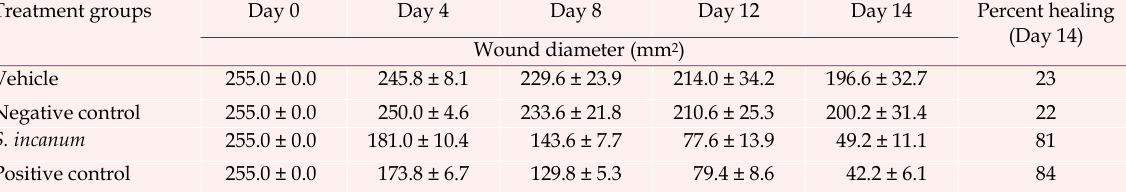
Average wound diameter and percentage contraction on different days of treatment with S. incanum , negative control, vehicle and positive control Treatment groups